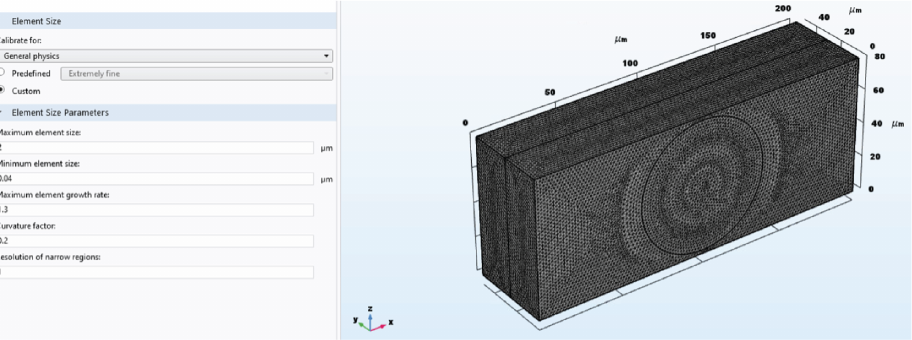
Figure A2. Meshing parameters and completed mesh of model